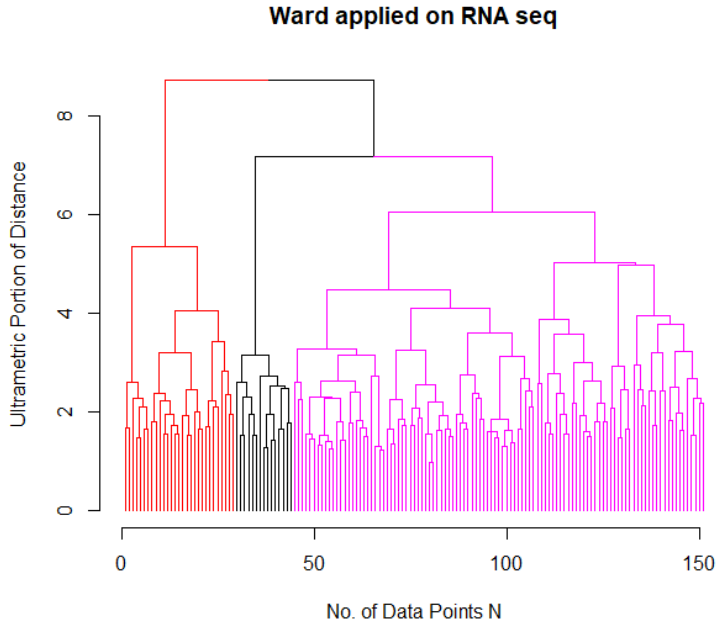
Figure 1. Ward clustering applied to the RNA-Seq data revealed a cluster structure of three groups G k , k = 1,2,3, one consisting only of APL and two of AML with the FAB classification of Table 1 which also depicts the colors of this figure. Clustering and dendrogram generation were computed with the R package “FCPS” available on the Comprehensive R Archive Network (CRAN) [19]. Table 1. Contingency table comparing Ward clustering of the RNA-Seq dataset and FAB classifica- tion [22] . Abbreviations: M0, undifferentiated acute myeloblastic leukemia; M1, acute myeloblastic leukemia with minimal maturation; M2, acute myeloblastic leukemia with maturation; M3, acute promyelocytic leukemia (APL); M4, acute myelomonocytic leukemia; M5, acute monocytic leuke- mia; M6, acute erythroid leukemia; M7, acute megakaryoblastic leukemia.